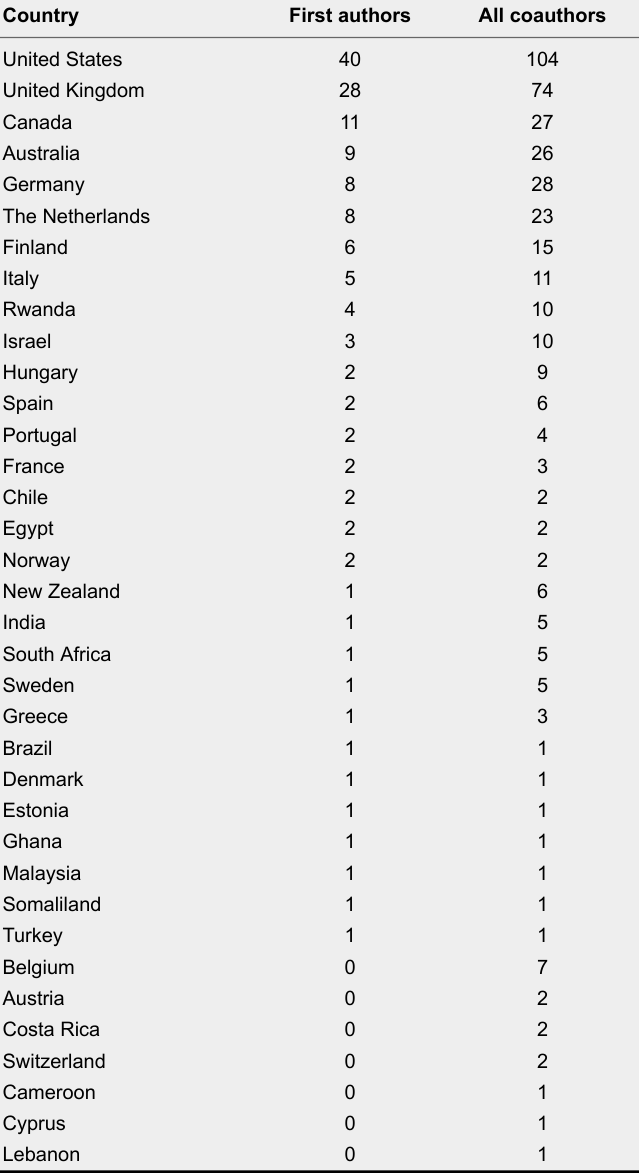
Location of the Authors Who Published in JSPP Between 2013 and 2017